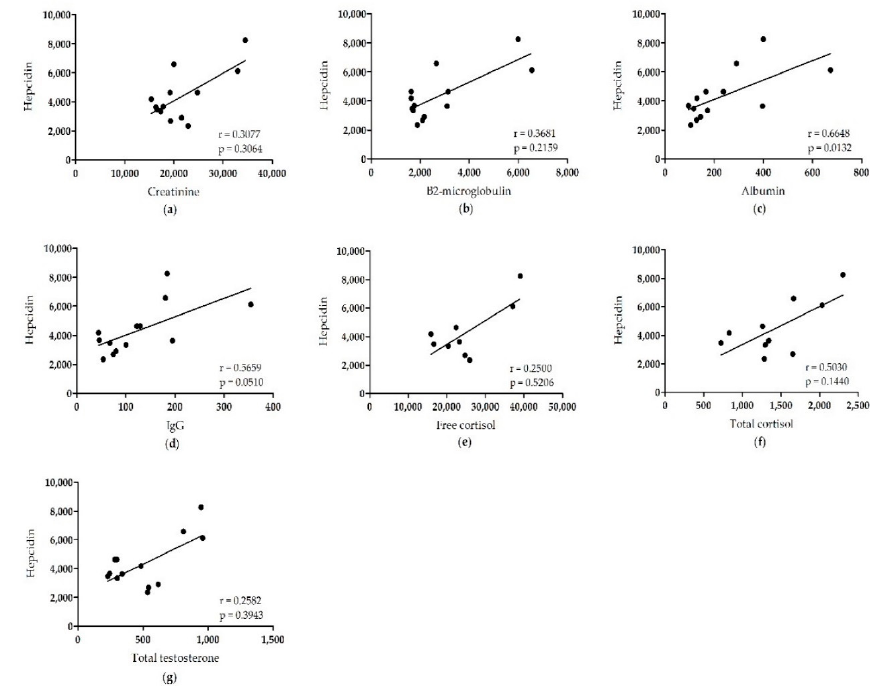
Figure 3. Correlations among the peritoneal clearance of hepcidin with all analytes in patients with end-stage renal disease undergoing a peritoneal equilibration test. The peritoneal clearance of hepcidin was correlated to the peritoneal clearance of ( a ) creatinine, ( b ) β 2-microglobulin, ( c ) albumin, ( d ) IgG, ( e ) free cortisol, ( f ) total cortisol, and ( g ) total testosterone. The strength of the correlation was measured using Spearman’s correlation coefficient (r).